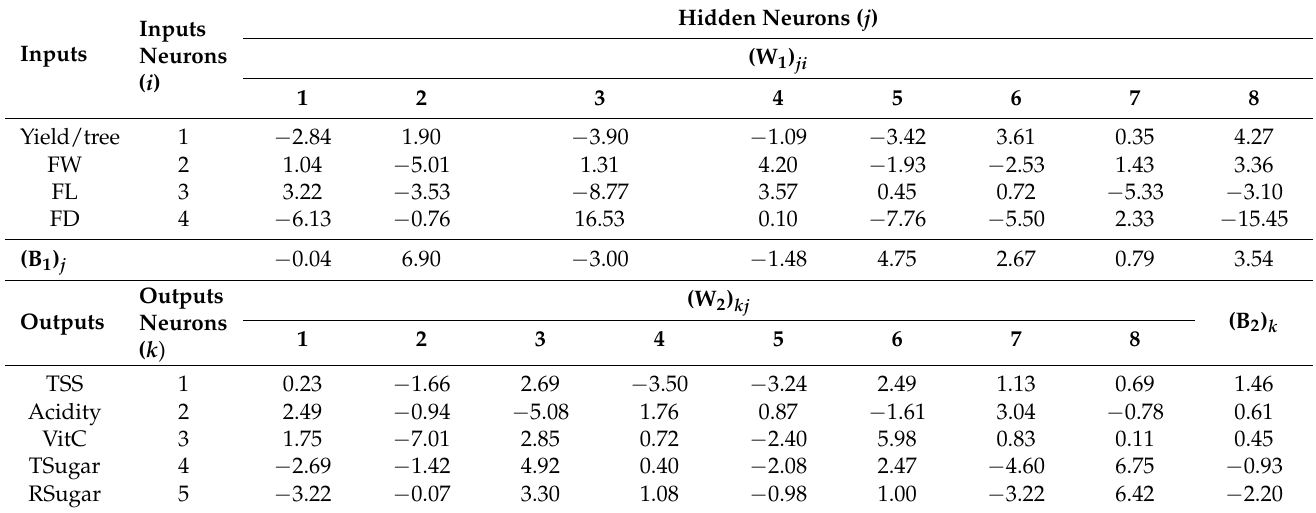
Table 5. Values of weights (W) and biases (B) between the layers for the developed ANN